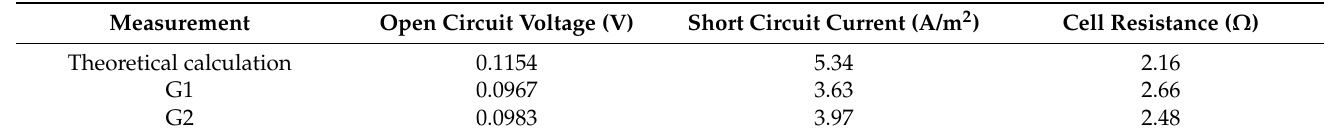
Table 3. Measurements of OCV, short circuit current, and cell resistance with each gasket geometry and theoretical calculations.